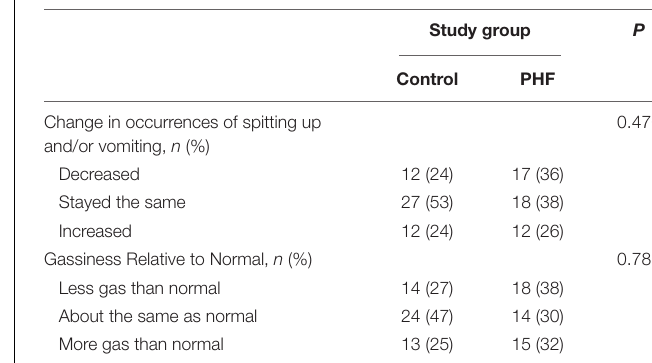
TABLE 4 | Changes in spitting up/vomiting and gassiness over the course of the